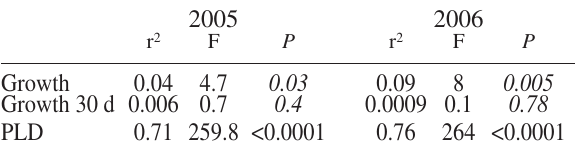
Table 2. – Summary of linear regressions between SAS (response variable) and Growth, Growth 30 d and PLD (predictive variables) from Coris julis recruits collected over two recruitment seasons at Varadouro (Faial